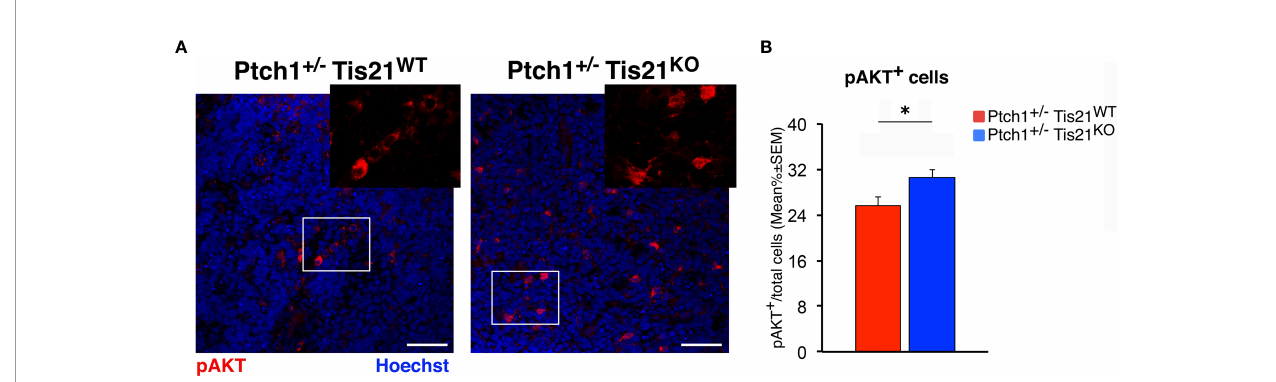
FIGURE 4 | Tis21 ablation in Ptch1 +/ − mice signi fi cantly increases phospho-AKT (at Ser473) expression in MBs. (A) Representative confocal images of the staining with the antibody against phospho-AKT (at Ser473; in red) and with the nuclear marker Hoechst 33258 (in blue) of MBs from Ptch1 +/ − /Tis21 WT and Ptch1 +/ − /Tis21 KO mice. Scale bar, 50 m m. White boxes, areas at higher digital magni fi cation (2×). (B) The phospho-AKT expression was quanti fi ed as mean ± SEM percentage ratio of the number of phospho-AKT staining cells to the total number of cells in each fi eld labeled by Hoechst 33258 in either Ptch1 +/ − /Tis21 WT or Ptch1 +/ − /Tis21 KO MBs.